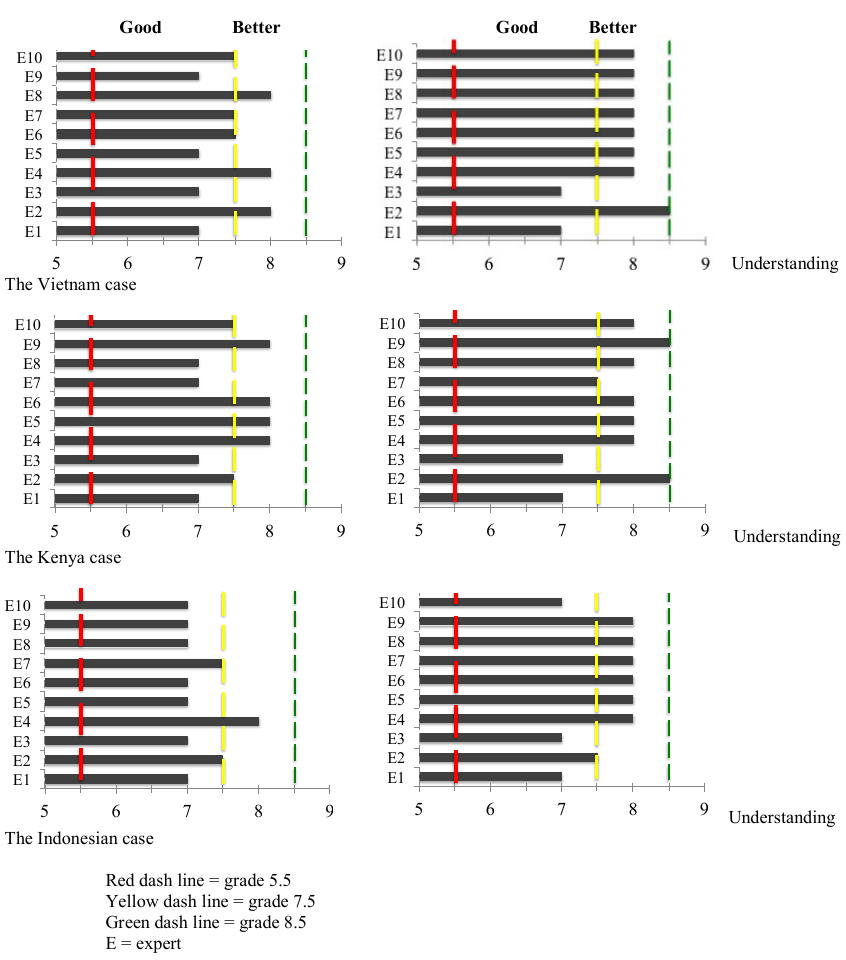
The Indonesian case Red dash line = grade 5.5 Yellow dash line = grade 7.5 Green dash line = grade 8.5 E = expert Figure 5. Summary of three cases; on the left: scenario 2, right: scenario